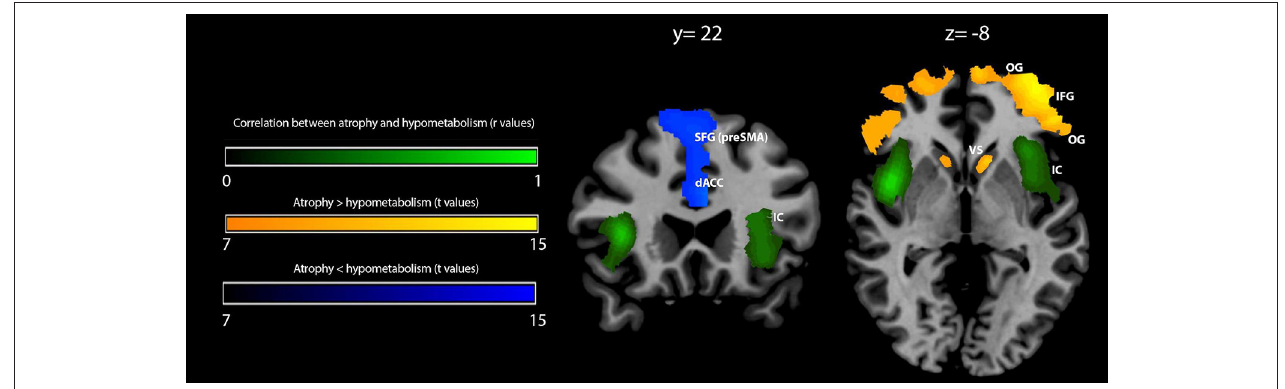
FIGURE 2 | Voxelwise correlation and comparison between gray matter (GM) density loss and hypometabolism in behavioral variant frontotemporal dementia (bvFTD) patients. Correlation between GM density loss and hypometabolism is shown in green (color spectrum represents r -values of significant voxels); prevalence of density loss over hypometabolism is shown in orange-yellow , while the reverse contrast (hypometabolism over atrophy) is shown in blue (related color spectra represent t -values of significant voxels). Maps are reported in accordance with radiological convention (i.e., left is right). MNI coordinates are on top of the panel . OG, orbital gyri; IFG, inferior frontal gyrus; IC, insular cortex; dACC, dorsal anterior cingulate cortex; SFG (pre-SMA), superior frontal gyrus (pre-supplementary motor area); VS, ventral striatum; MNI, Montreal Neurological Institute.